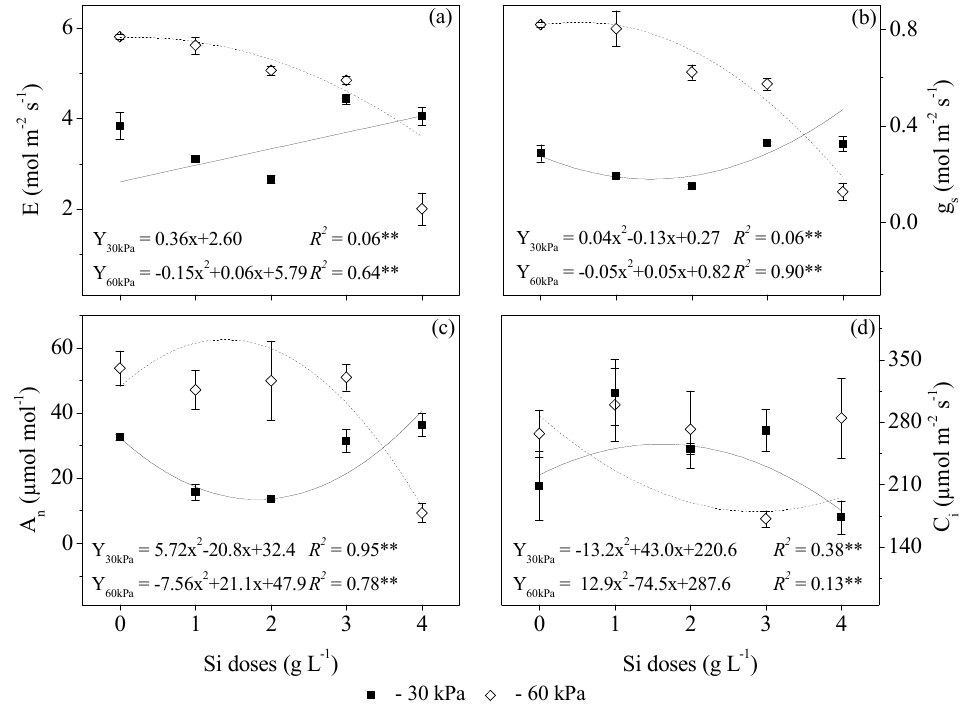
Figure 5. Responses of the transpiration rate ( a ), stomatal conductance ( b ), net photosynthesis assimilation rate ( c ), and the internal concentration of CO 2 ( d ) for different doses of Si (g L − 1 ) subjected to two levels of water restriction ( − 30 and − 60 kPa) at 48 DAT. (**) significant at 1% by F test.